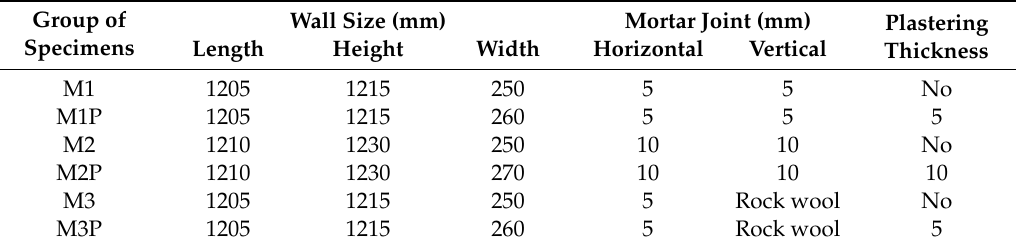
Table 1. Details of AAC self-insulation block masonry specimens.